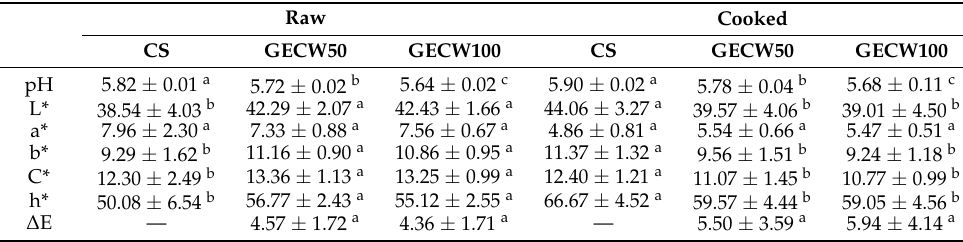
Table 4. Physic-chemical properties of raw and cooked beef burger elaborated with cocoa bean shell flour and walnut oil emulsion gel as partial and total pork backfat replacers. Raw Cooked CS GECW50 GECW100 CS GECW50 GECW100